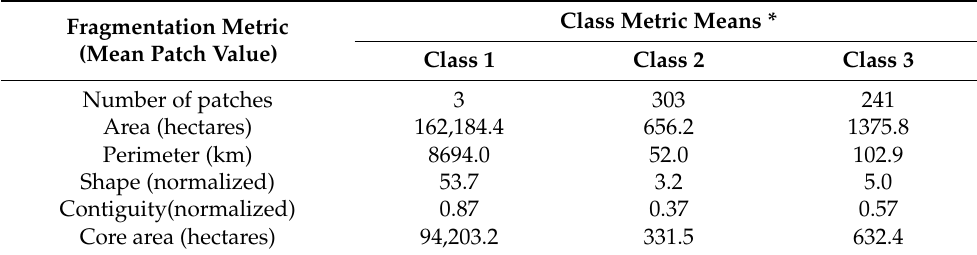
Table A5. Fragmentation metrics of the selected 547